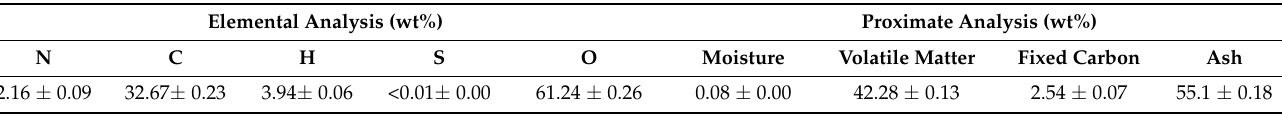
Table 2. Ultimate and proximate analysis of the milled